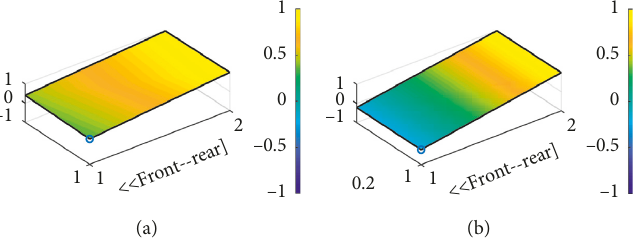
Figure 16: Modal parameters identified by ACS-SSI. (a) 1.64Hz, 21%. (b) 2.133Hz, 17%.